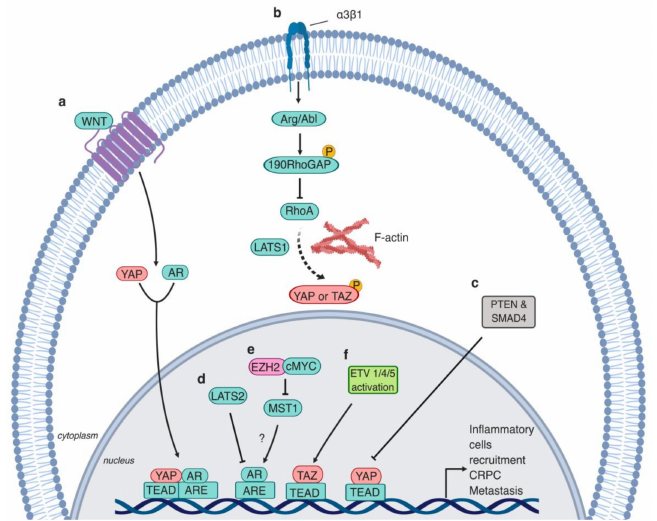
Figure 4. The Hippo pathway regulation of advanced prostate cancer. a. During androgen